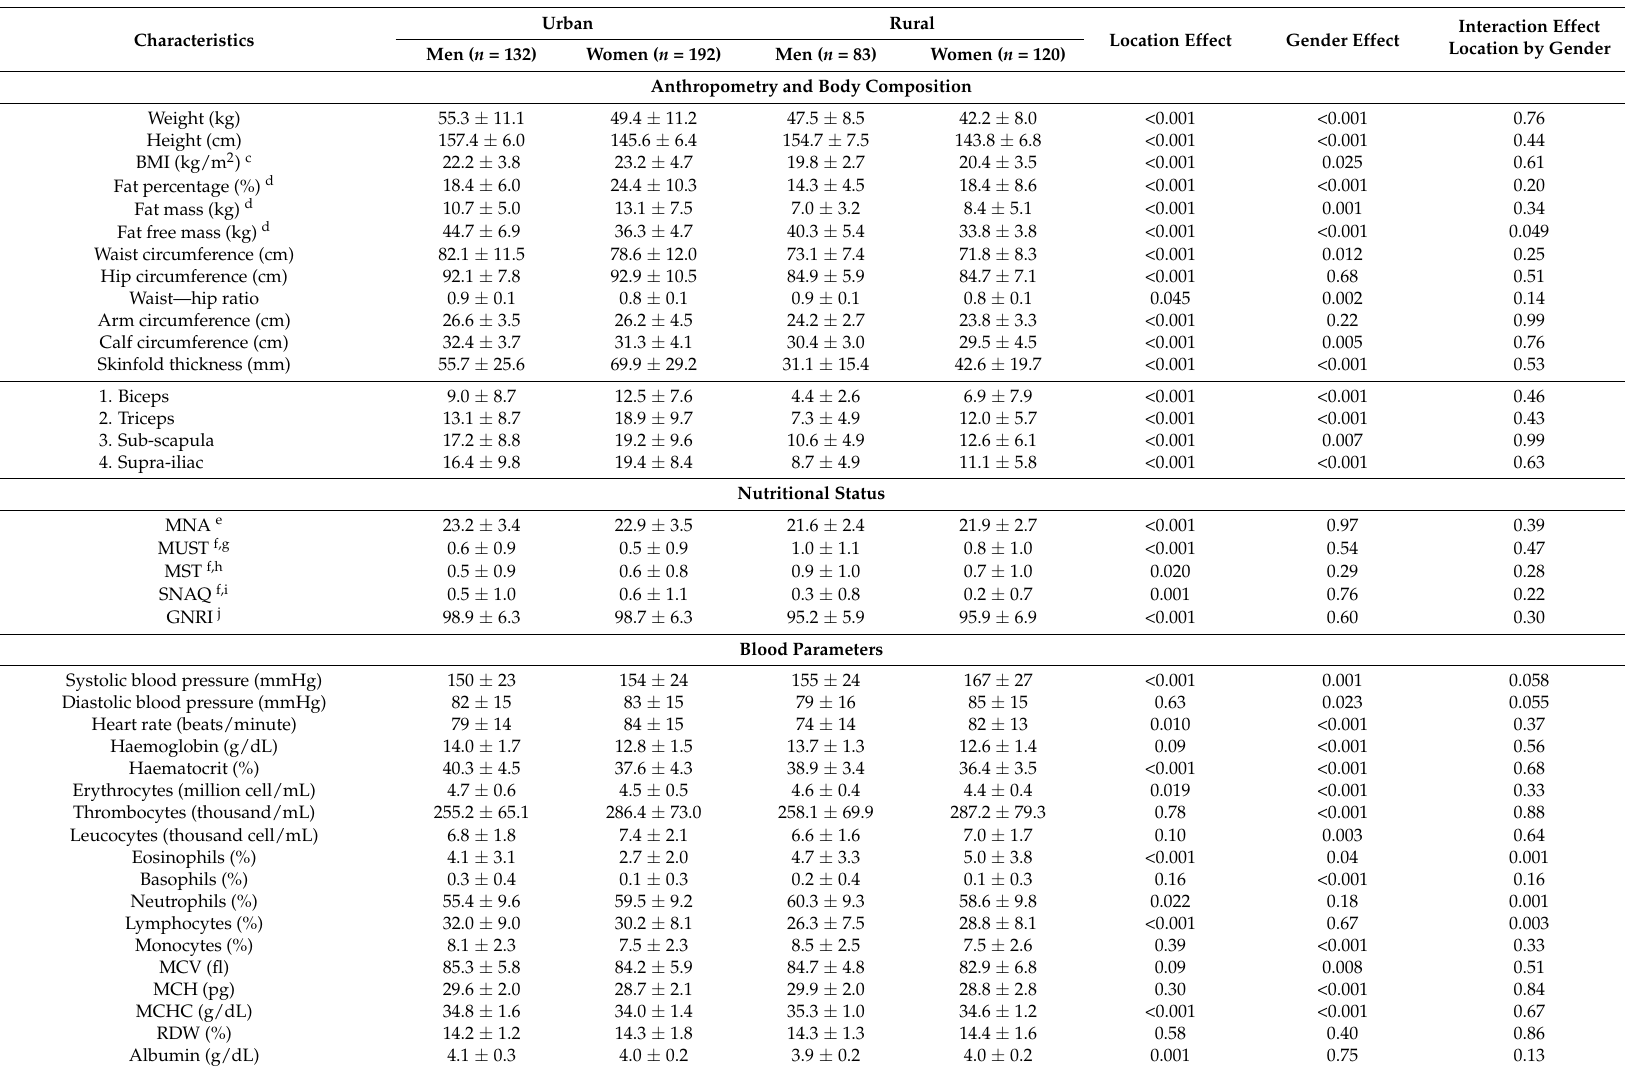
Table 2. Anthropometric characteristics, nutritional, functional and mental status, and blood parameters a,b .